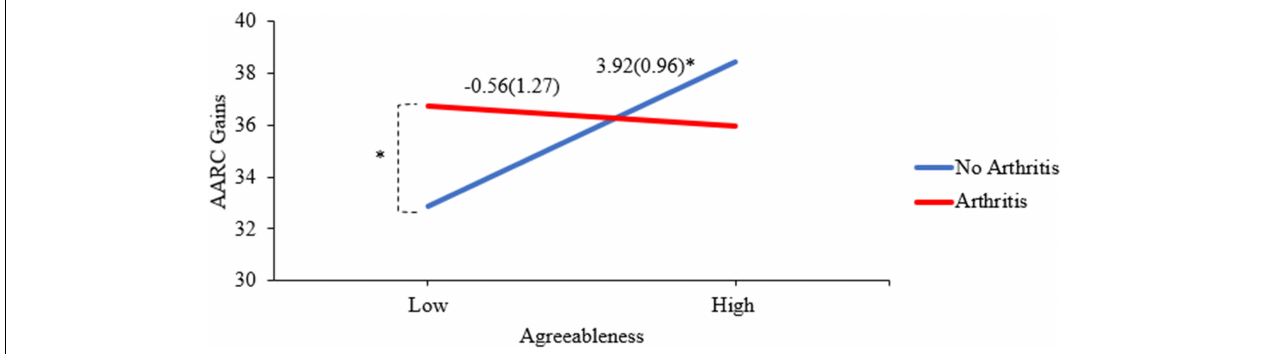
FIGURE 1 | Interaction of arthritis and agreeableness predicting AARC gains. ∗ p < 0.01. The y -axis values reflect predicted AARC gain scores. The slope values and (standard errors) appear above the lines for those with and without arthritis. The points were derived from predicting the values using low (Mean–1 SD) and high (Mean + 1 SD) values of agreeableness for those with and without arthritis, as recommended by Preacher et al.